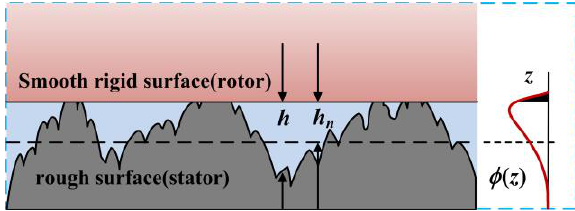
Figure 3. Contact between a smooth rigid surface and a rough surface.